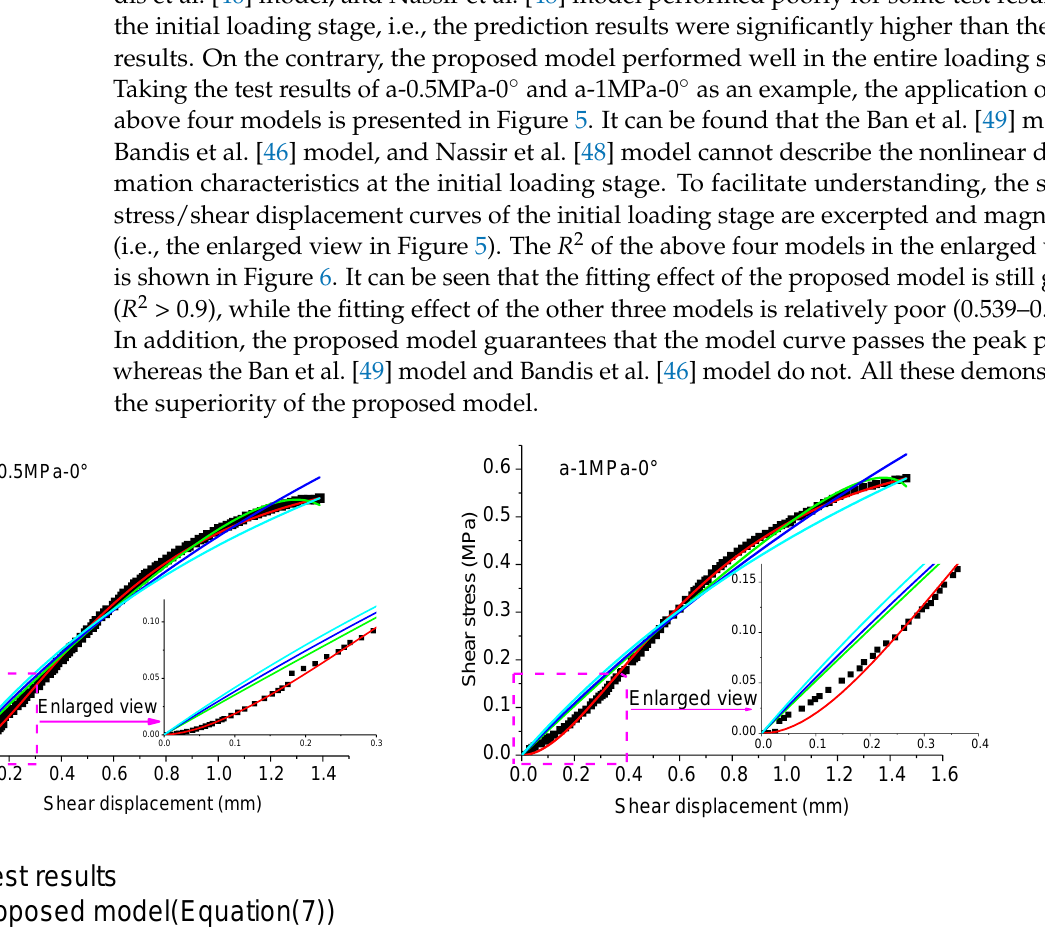
Figure 6. R 2 of each model. 4. Discussion The shape of the pre-peak shear curve of rock joints depends on roughness, mechan- ical properties, geological environment, and other perturbation factors. Subjected to cer- tain environmental factors, such as freeze – thaw and immersion, the pre-peak constitutive curve of rock joints is reflected in a convex-type curve. During the initial loading stage, the hangingwall and footwall of rock joints are compressed, and the internal pores and cracks are compacted. This results in a downward concave shear stress/shear displace- ment curve, and the tangent slope of the curve increases as the shear displacement is ap- plied [72]. There would be a significant error induced by the use of Equations (8) – (10) when describing the pre-peak mechanical behavior of such joints.